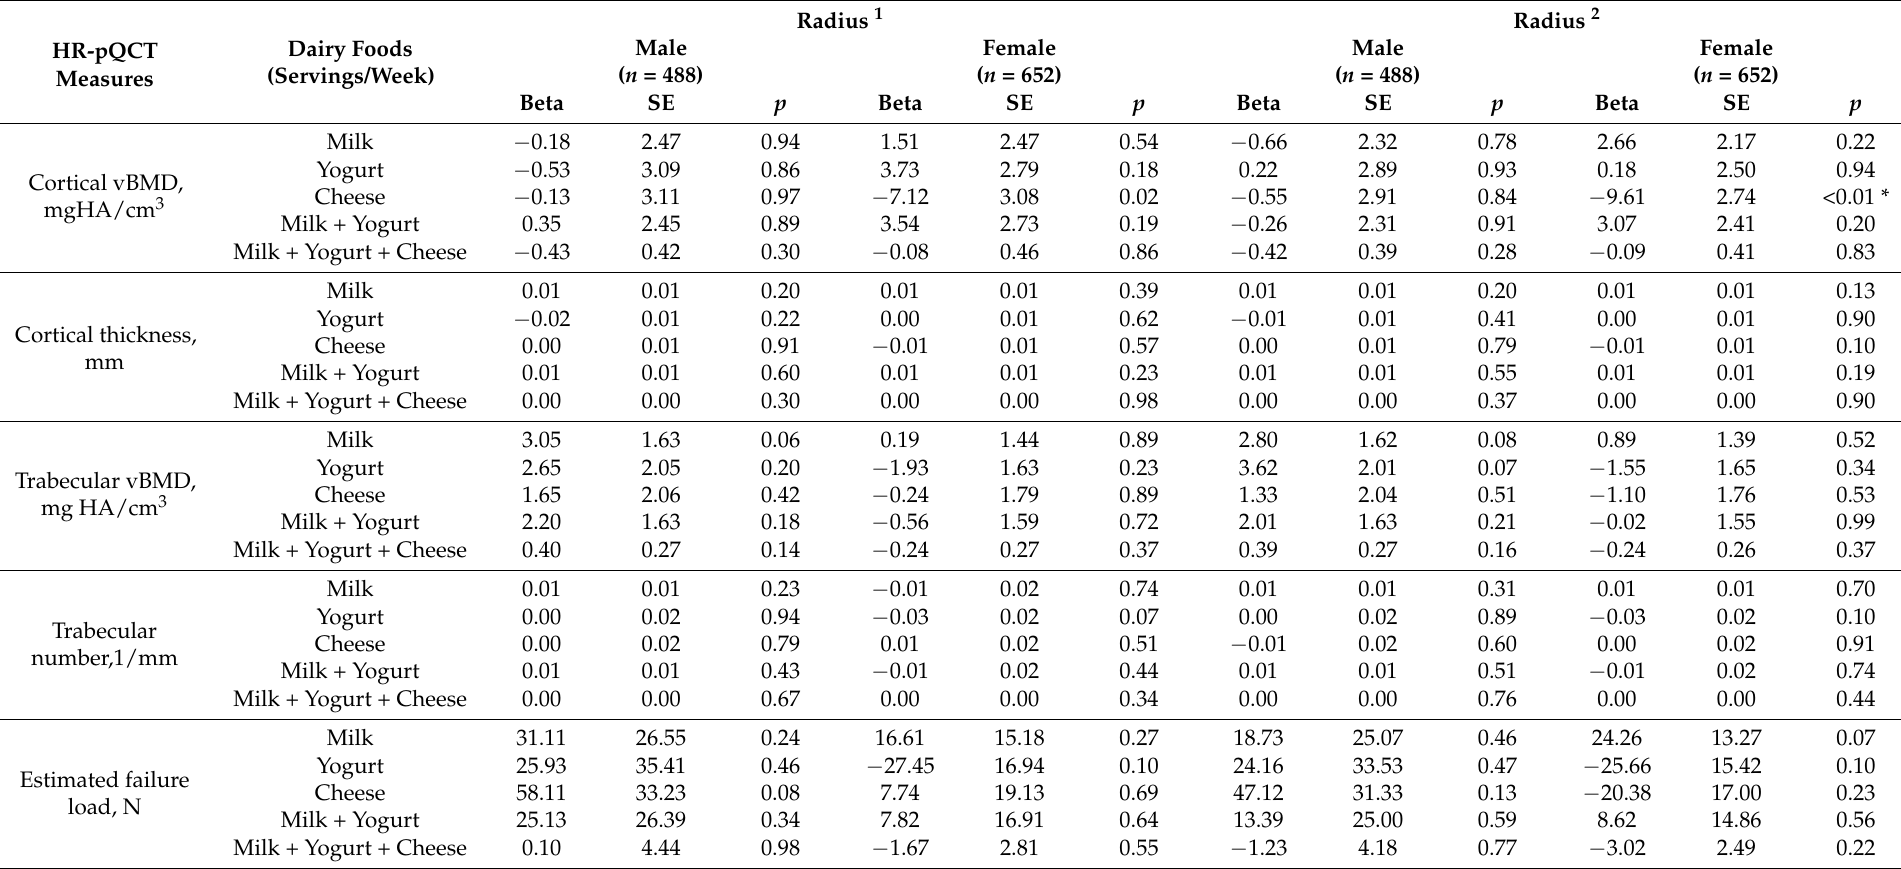
Table 2. Association of dairy food intake with measures of radial HR-pQCT in men and women from the Framingham Offspring Study.